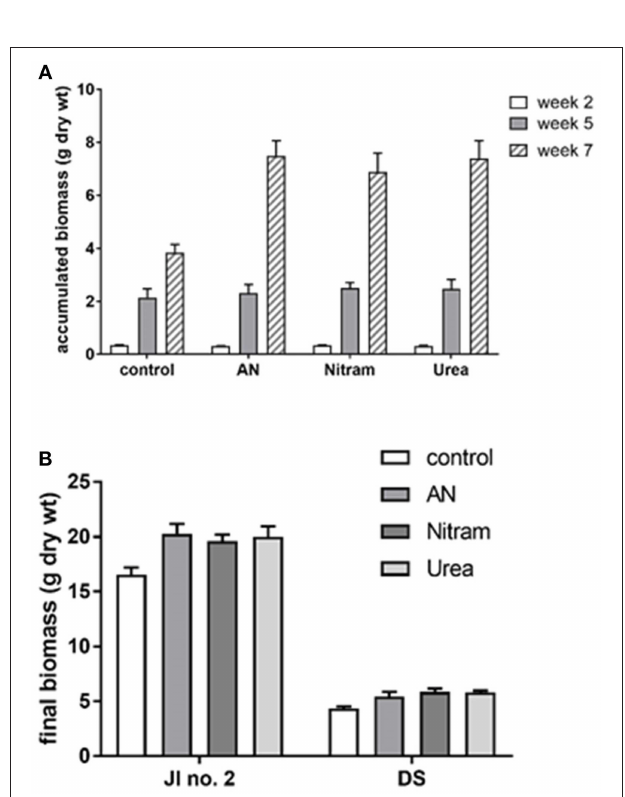
FIGURE 8 | Accumulated biomass of a grass turf treated with AN, Nitram, Blue Urea, and non-treated control. (A) JI no. 2 standardized compost; (B) comparison of JI no. 2 with degraded soils (DS) (bar = SEmean, n = 5 JI no. 2, n = 3